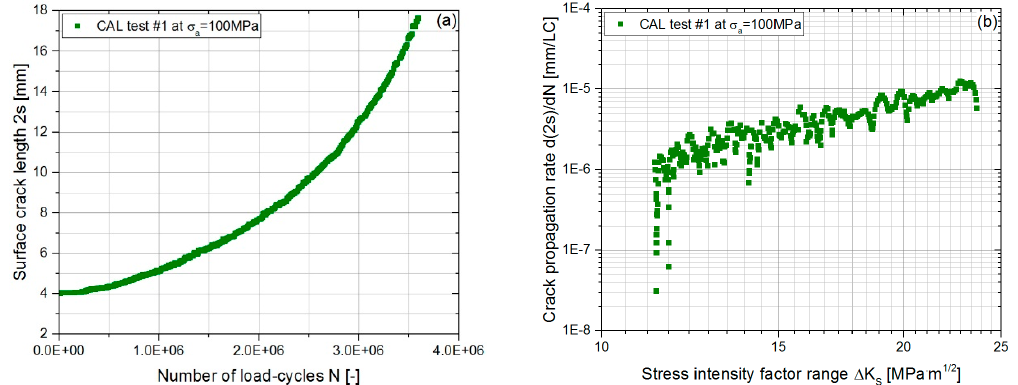
Figure 1. Results of amplitude load tests (CAL) test #1 at load of σ a = 100 MPa ( a ) surface crack length vs. load-cycles; ( b ) crack propagation rate versus stress intensity factor.